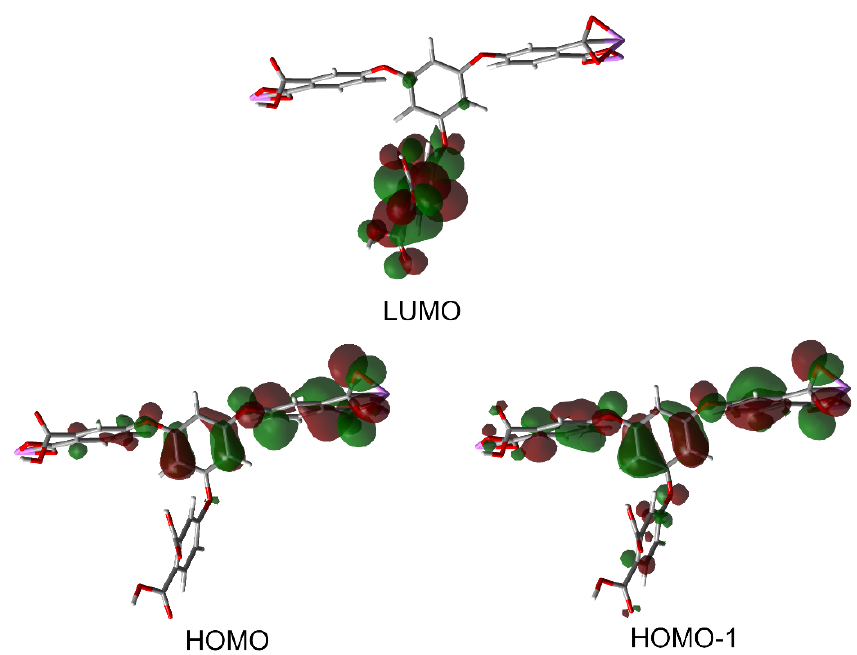
Figure 5. Isosurfaces (at 0.02 e/Bohr 3 ) of the molecular orbitals of Li 3 H 3 L ground state calculated at B3LYP[GD3BJ] 6–31 + G(d) level of theory.